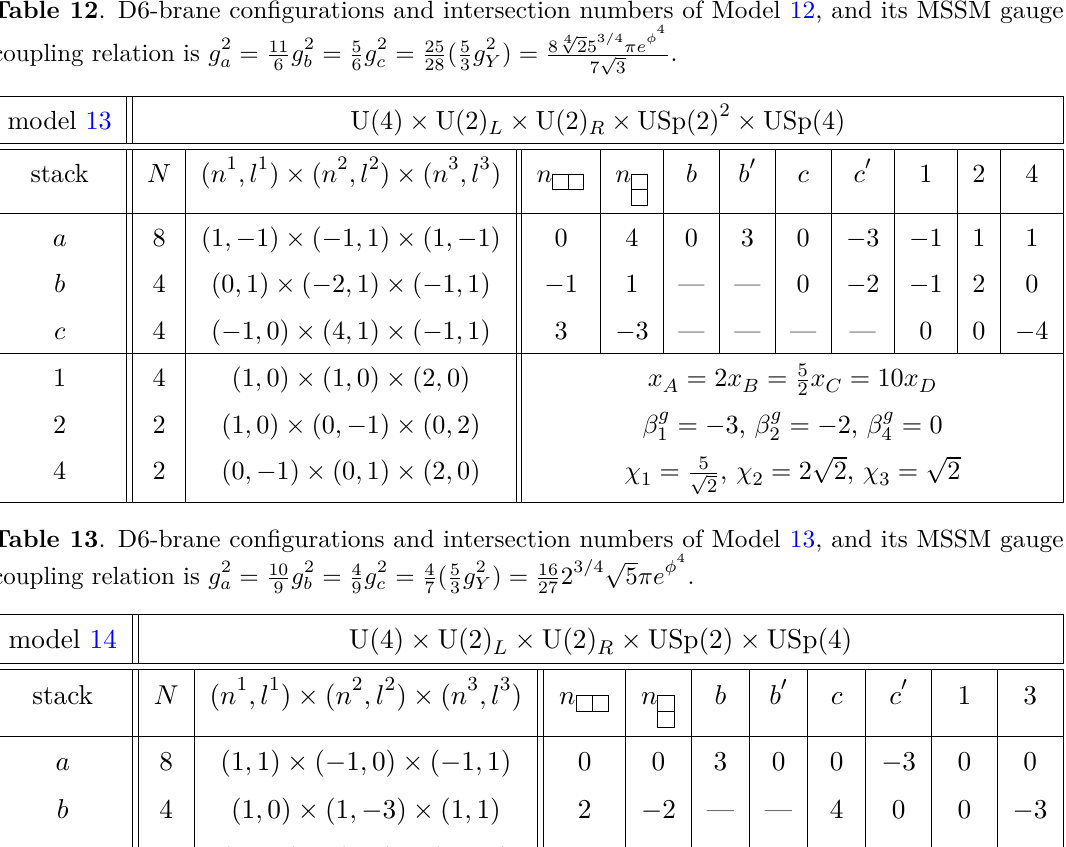
Table 12 . D6-brane configurations and intersection numbers of Model 12, and its MSSM gauge